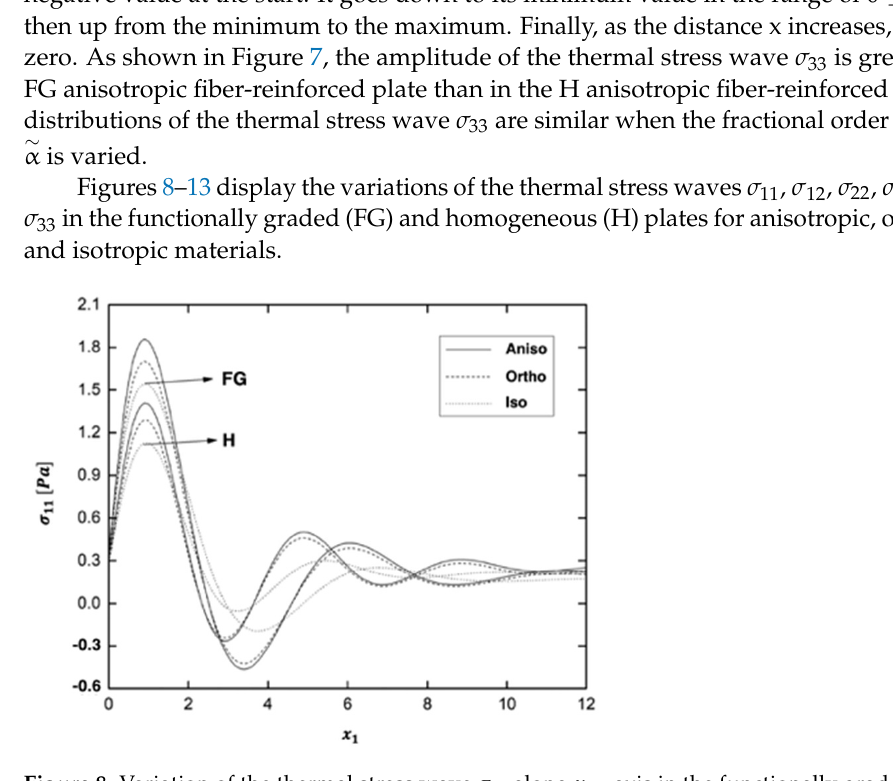
Figure 7. Variation of the thermal stress wave 𝜎 (cid:2871)(cid:2871) along 𝑥 (cid:2869) – axis in the functionally graded (FG) and homogeneous (H) anisotropic fiber-reinforced plates under different fractional order parame- ters.